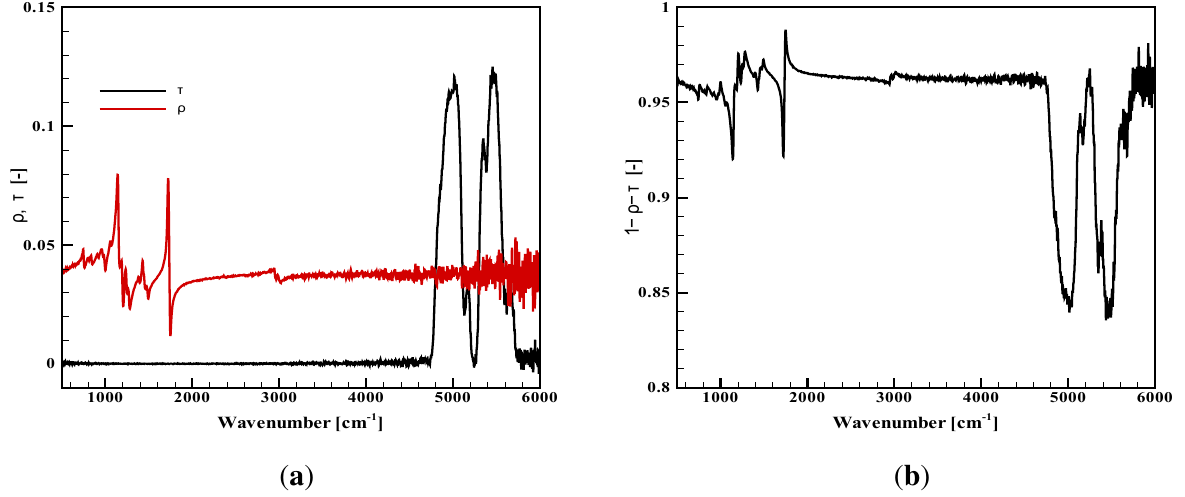
Figure 3. Radiative properties of the virgin PMMA slab, 15 mm thick. ( a ) Transmittance and reflectance; ( b )